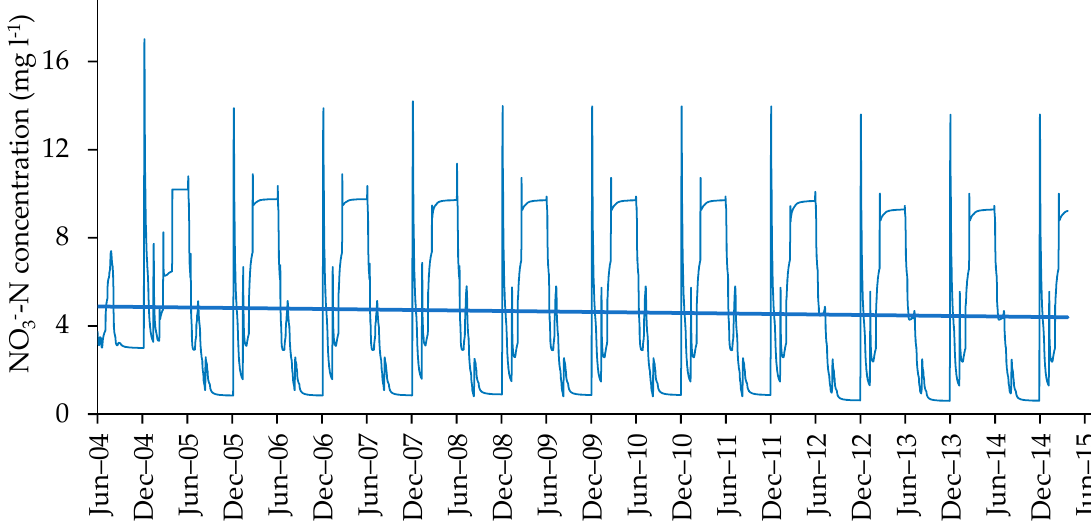
Figure 7. Temporal predictions of groundwater NO 3 − -N concentration of the study area. The solid blue line represent the linear trendline over the period.